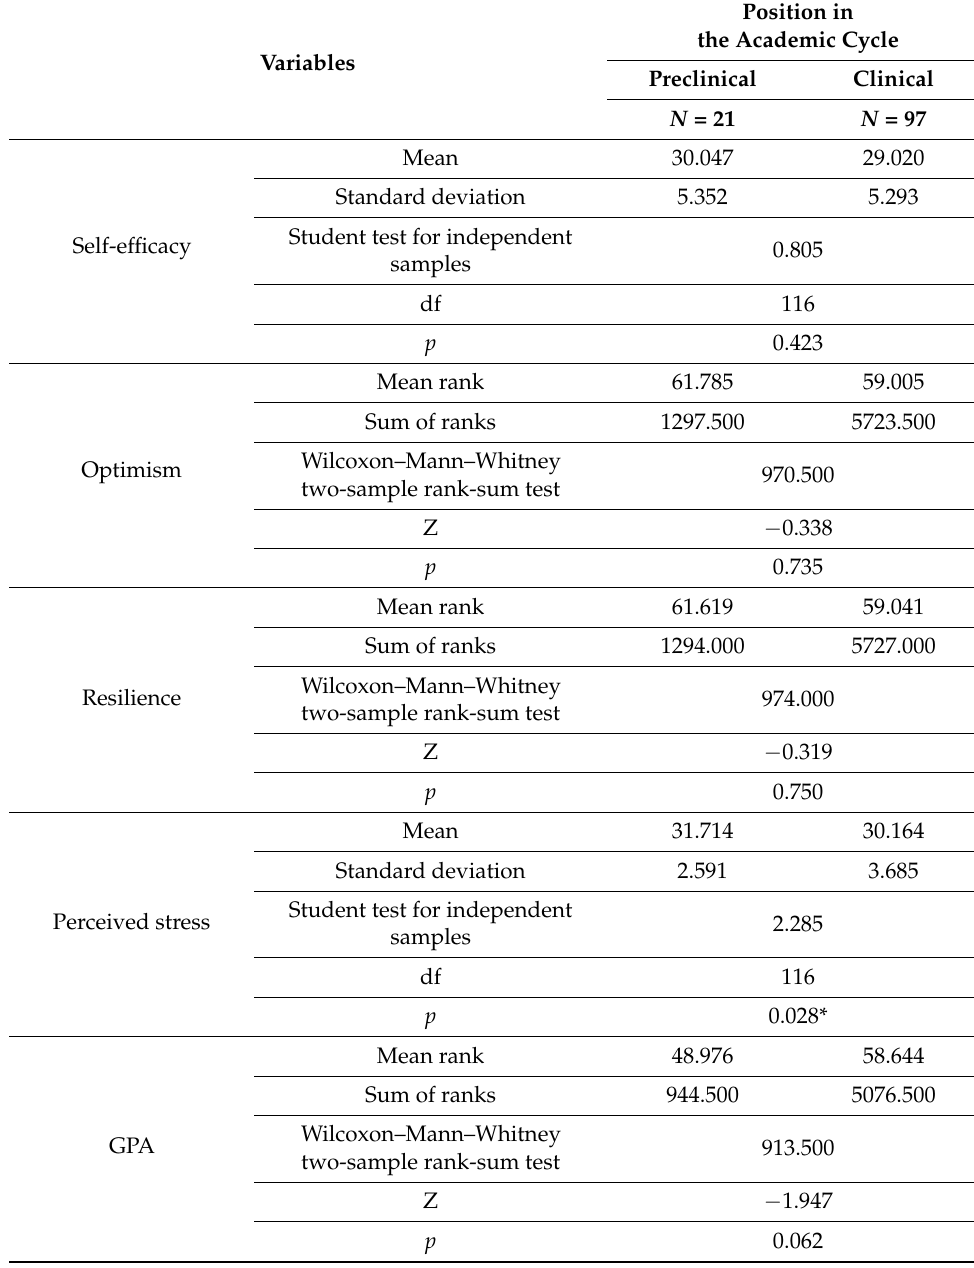
Table 7. Analysis of variables by position in the academic